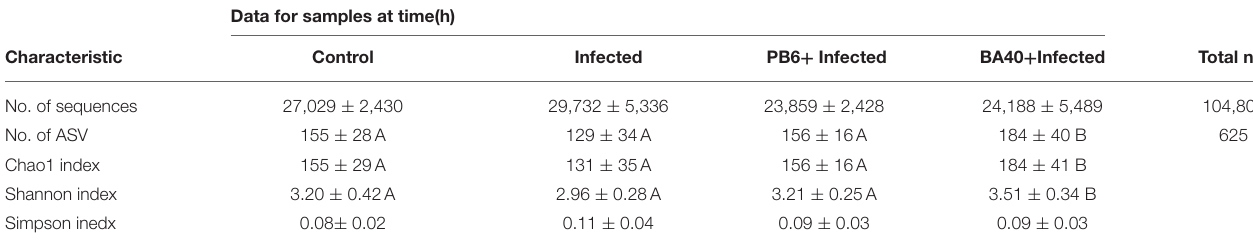
TABLE 2 | Characteristics of amplicon libraries in the bacteria community. Data for samples at